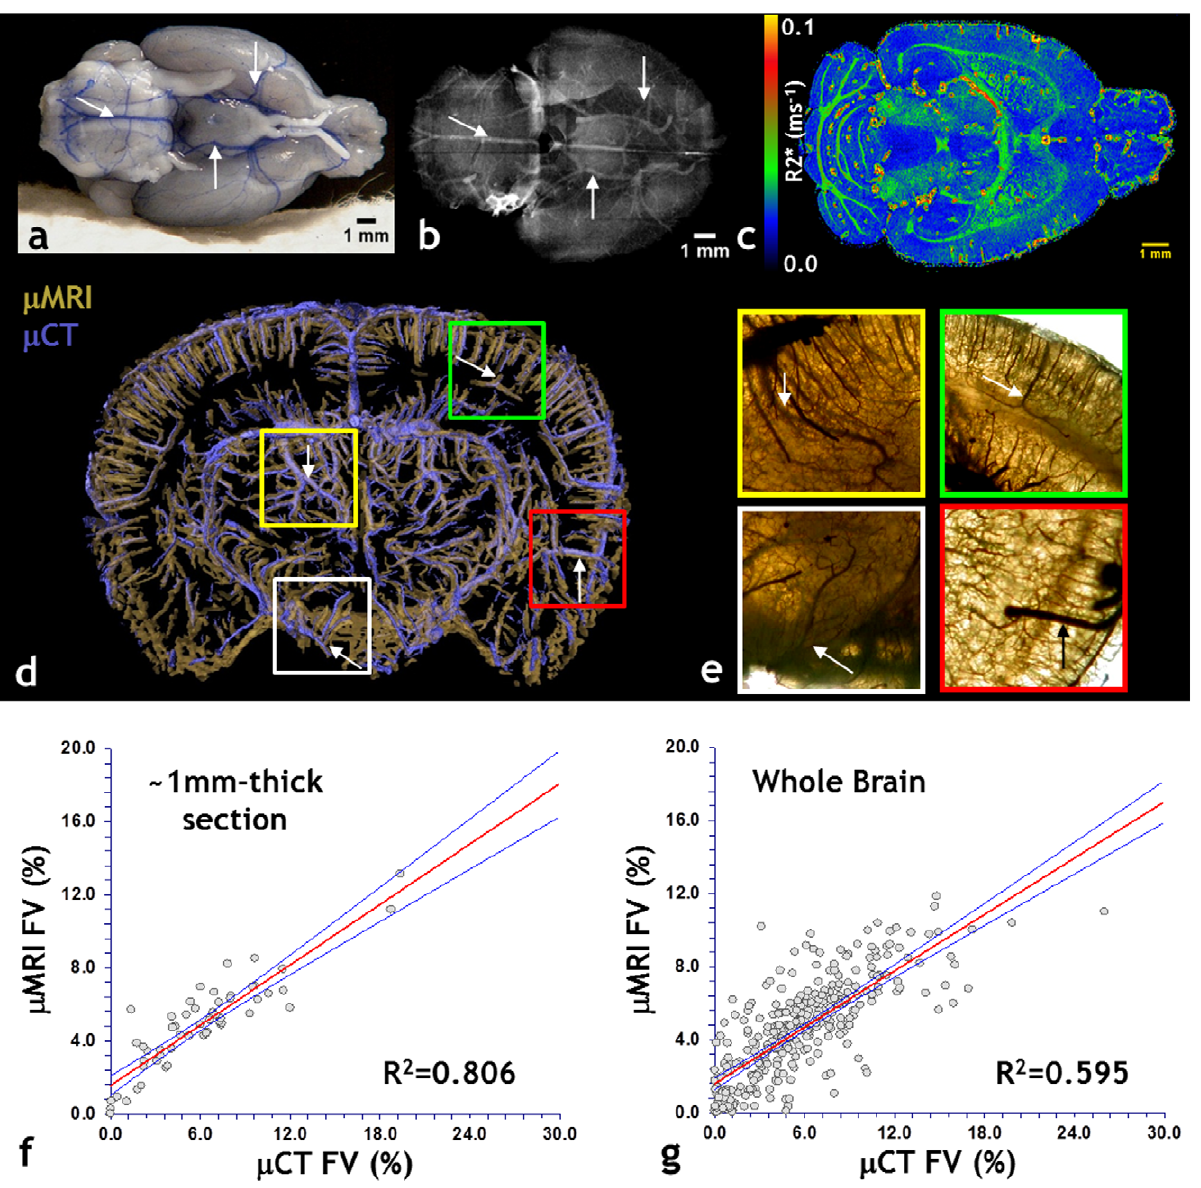
Figure 1. 3D imaging of the murine neurovasculature with m MRI and validation with m CT and optical microscopy. (a) Photograph of a freshly excised mouse brain showing blue Microfil H perfused vessels (arrows). (b) X-ray radiograph of the same brain in which radio-opaque microfilled vessels are clearly visible. Arrows indicate major vessels that are also visible in (a). (c) Slice through the 3D R 2 * map of the same brain. The Microfil-brain tissue interface is characterized by elevated R2* (hot colors) values. Note that background voxels are assigned R2* of zero. (d) , 1.2 mm slab from another intact brain, in which m MRI-derived vasculature (gold) is overlaid on that acquired using m CT (purple). One can clearly visualize the vascular architecture and the agreement between m MRI and m CT. (e) Bright-field images (2 6 ) of ROIs corresponding to colored squares in (d). Images are from a 1 mm thick, unstained brain section. Dark microfilled vessels provide corroboration of the m MRI data in (d). Arrows indicate major vessels that are also visible in (d). m CT data were resampled to match the m MRI spatial resolution, and the fractional vascular volume (FV) computed within 8 6 8 6 1 subvolumes for each dataset. The correlation between the m MRI and m CT-derived FVs for the 1 mm thick slice is plotted in (f). A similar analysis was conducted for the whole brain, wherein the FV was computed within 8 6 8 6 8 subvolumes for each dataset. The correlation between the m MRI and m CT-derived FVs for the whole brain is plotted in (g) and demonstrate good agreement between m MRI and m CT-derived vasculature. The red lines in (f) and (g) are the best linear fit to the data, and blue lines indicate the 95% confidence limits about the mean. doi:10.1371/journal.pone.0022643.g001 that in the contralateral brain ( Fig. 4c–d ). The 2D histogram ( Fig. 4e ) reiterates the trend in the blood volume measured using these independent methods and illustrates the correlation between them. Fig. 5 illustrates the range of spatial resolutions that one can span, with in vivo MRI at one end, and ultra-high resolution m MRI at the other end of the spatial resolution spectrum.